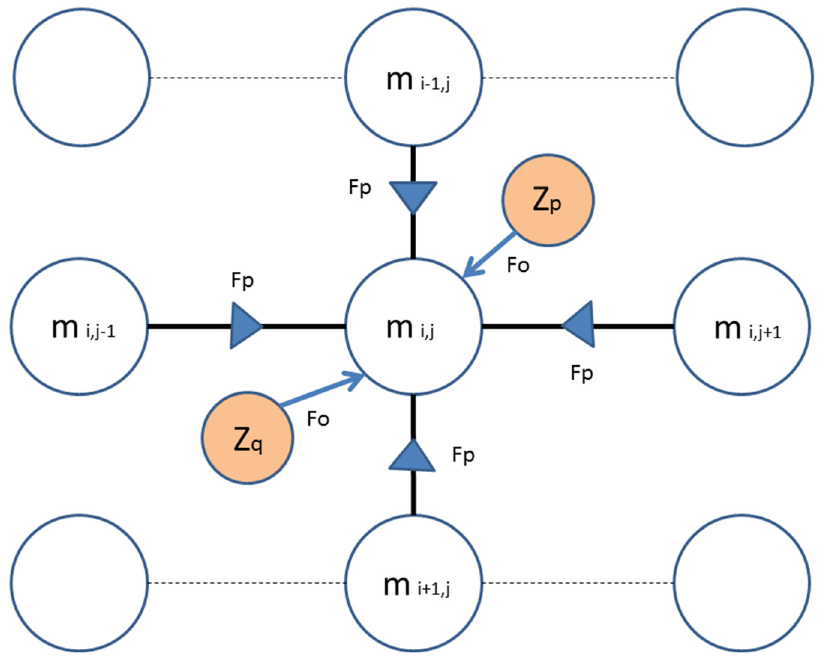
Figure 6. GMRF graph corresponding to 4-neighbourhood scheme for a grid point at row i and column j.